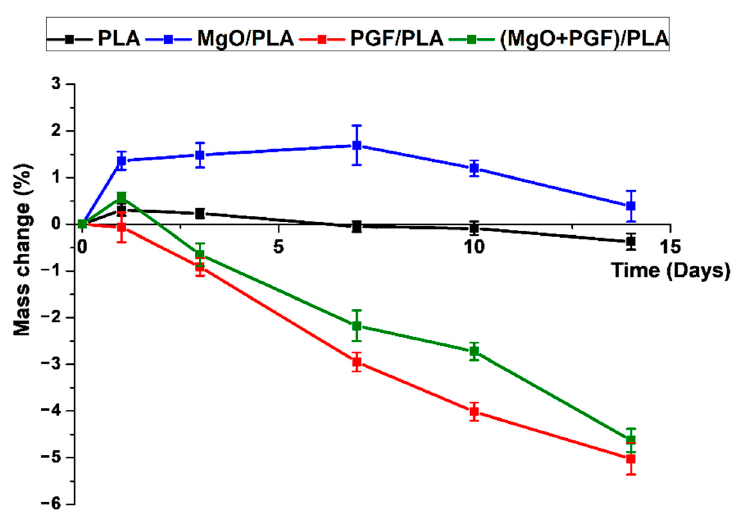
Figure 10. Mass change profile of scaffolds during 14 days of in vitro degradation in Tris-HCl buffer under 37 °C.